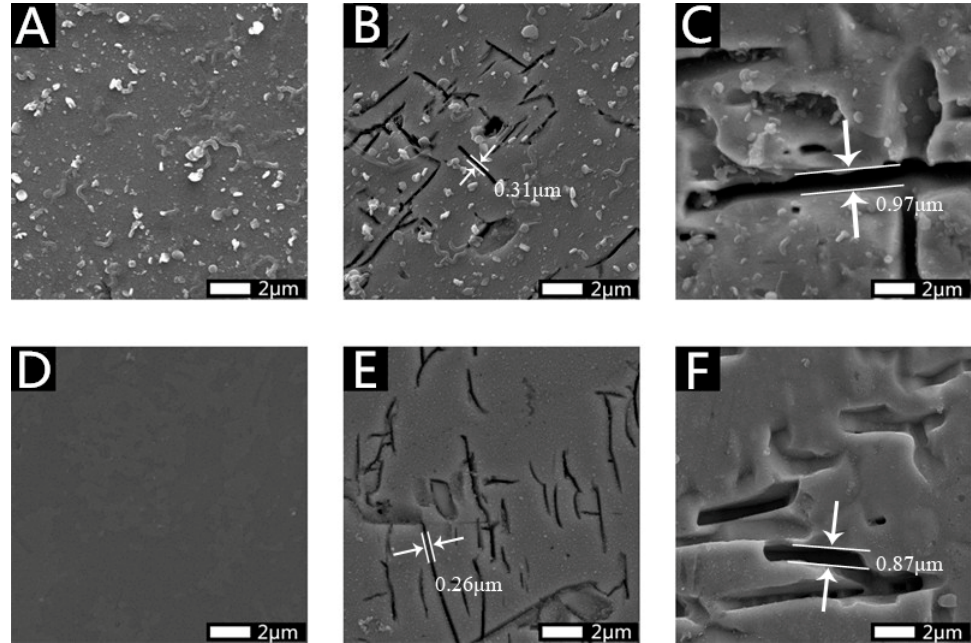
Figure 3. SEM photos of pyrite after leaching under different conditions: with attached microbes under ( A ) 650 mV, ( B ) 750 mV and, ( C ) 850 mV; without attached microbes under ( D ) 650 mV, ( E ) 750 mV and, ( F ) 850 mV.